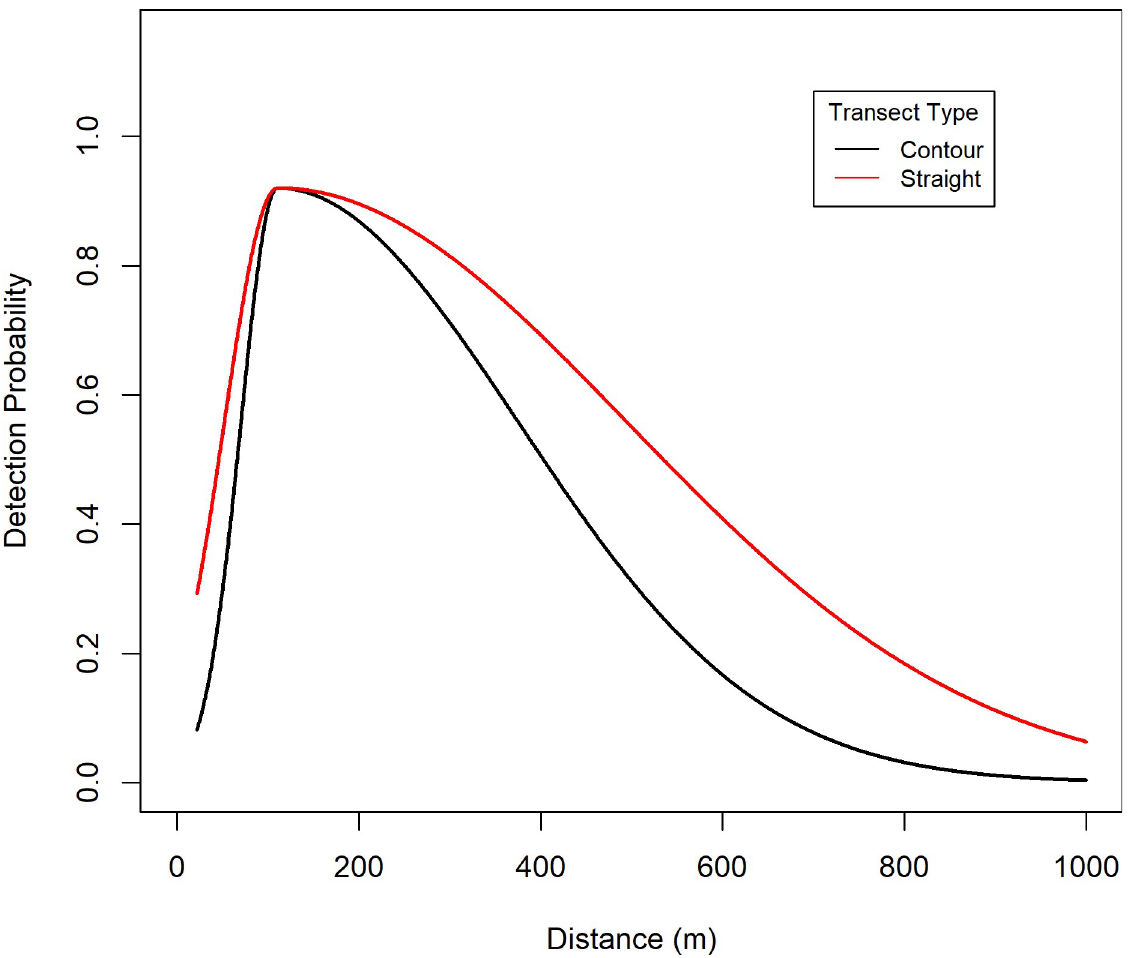
Fig 6. Estimated detection of brown bears in Game Management Unit 9D and 10, Southwest Alaska, by transect type, from a spring 2002 distance sampling survey. Contour transects were flown in mountainous terrain; straight/hinged transects were flown over flatter